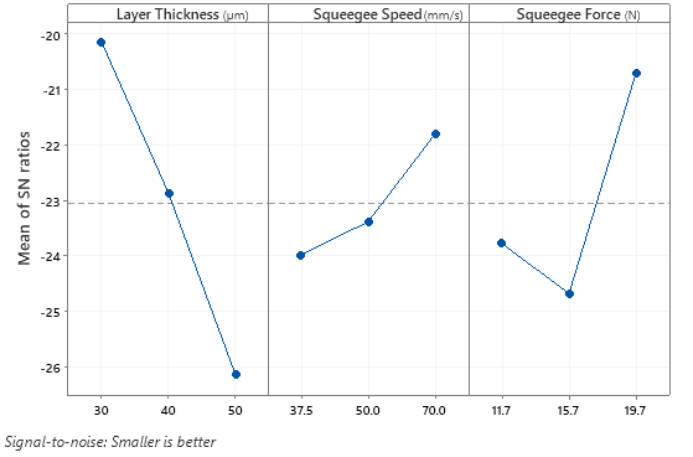
Figure 6. Main effects plot for S/N ratios. Table 3. Confirmation of predicted SAM settings.